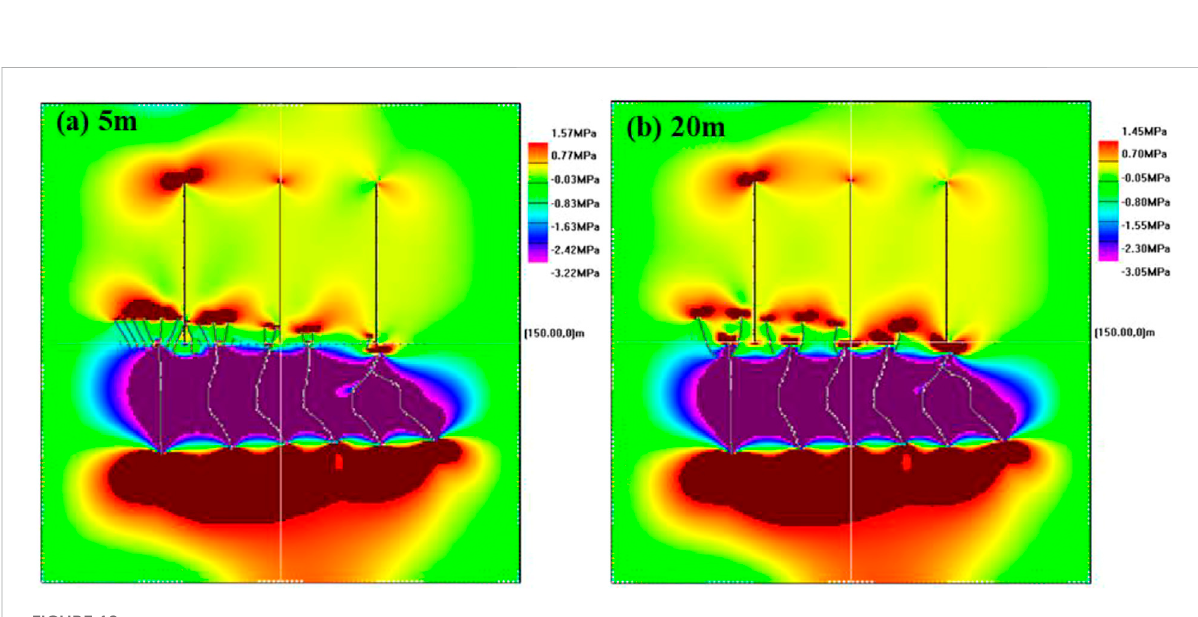
FIGURE 18 Normal stress in the X-axis direction under different natural fracture